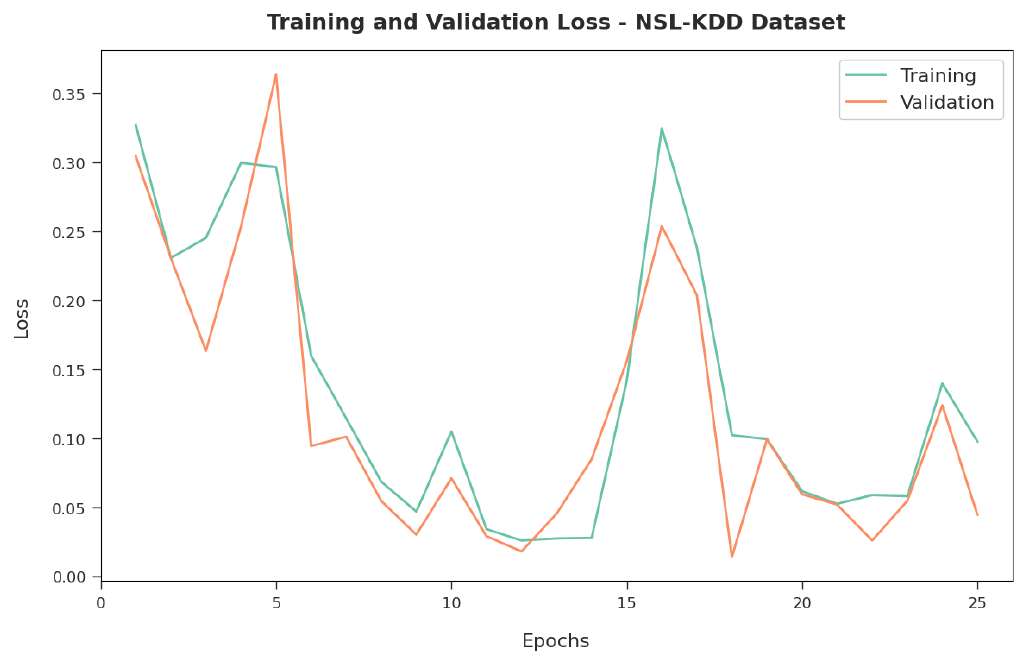
Figure 5. TL and VL analysis of OMLIDS-PBIoT technique under NSL-KDD dataset.